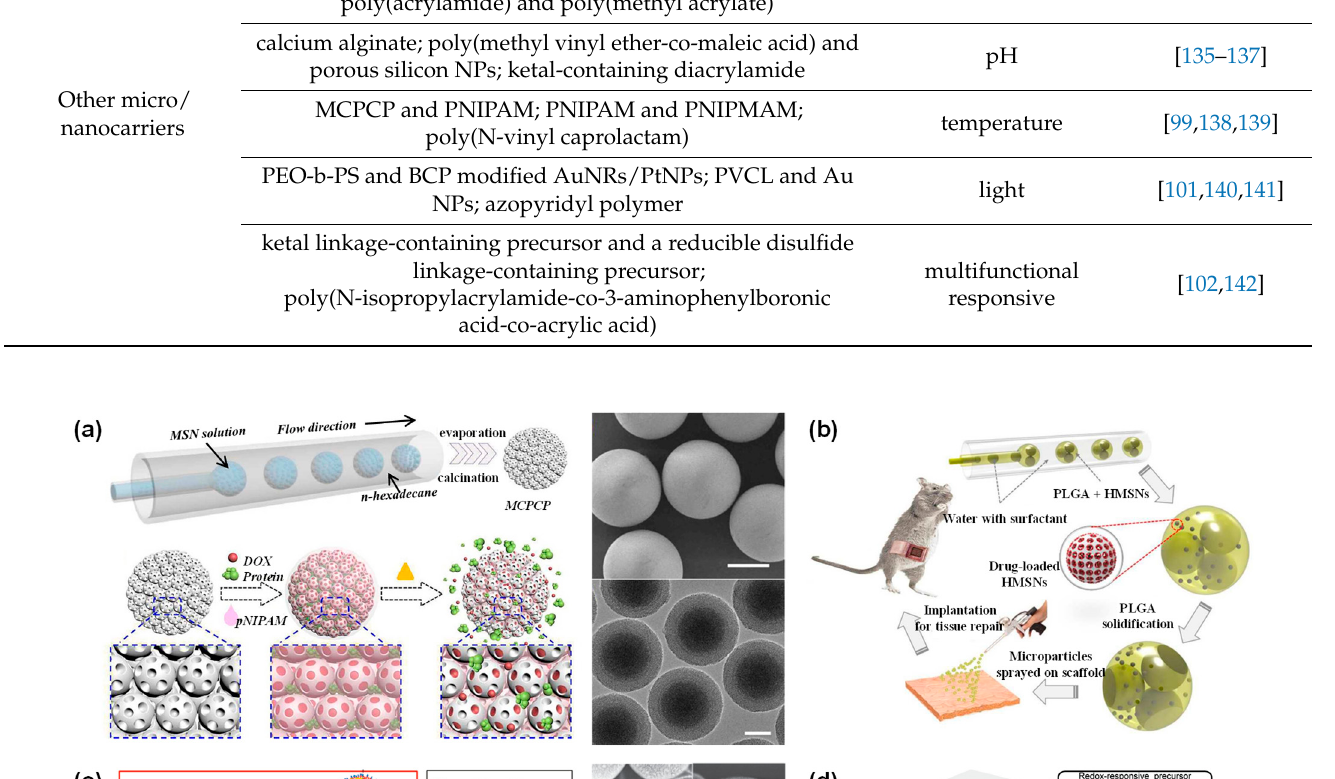
Figure 1. ( a ) Schematic diagram of silicon-based microfluidic device. Reproduced with